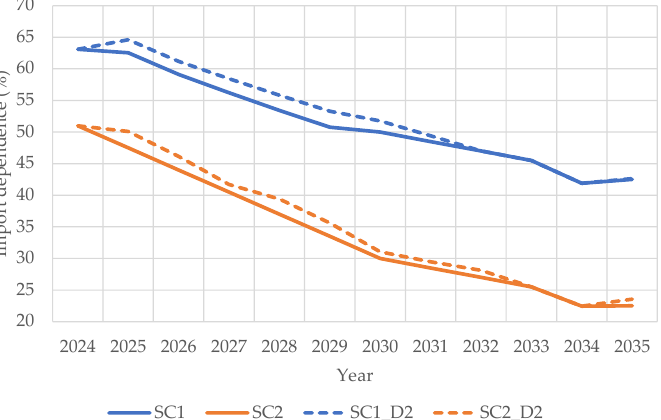
Figure 5. Import dependence (%) in the case of the loss of natural gas supply.